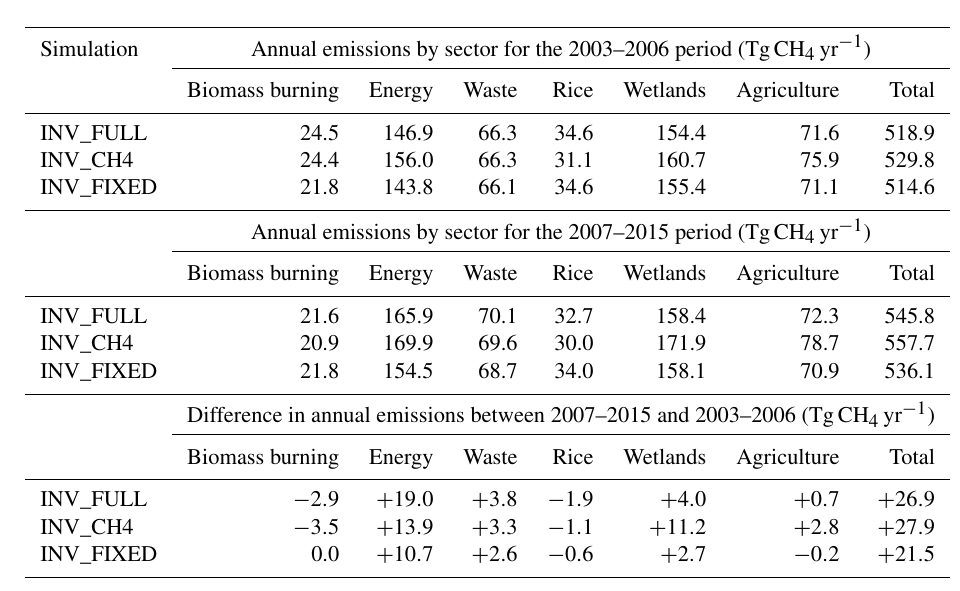
Table 6. Posterior annual CH 4 emissions for the period of near-zero atmospheric growth (2003–2006) and the renewed growth (2007–2015) based on three different inversion simulations. Note the total emissions include the supplementary emissions (geological, hydrates, oceans, and